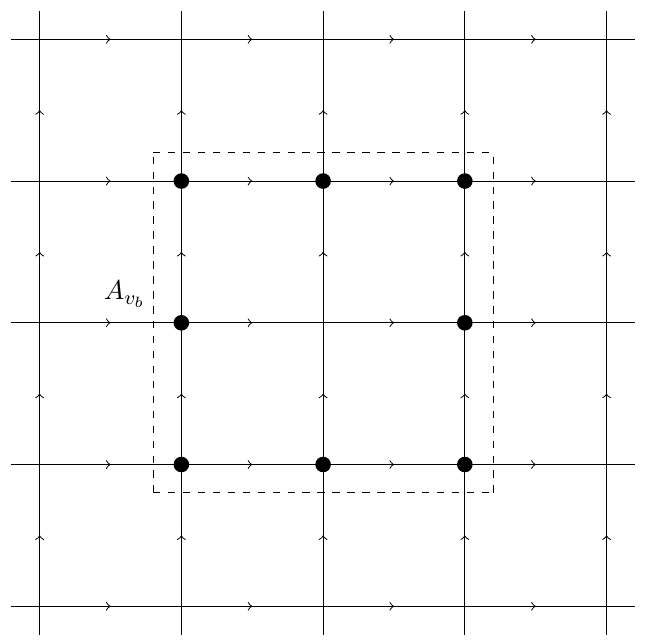
Figure 2 . Region R is enclosed by the dashed line. It has the topology of a